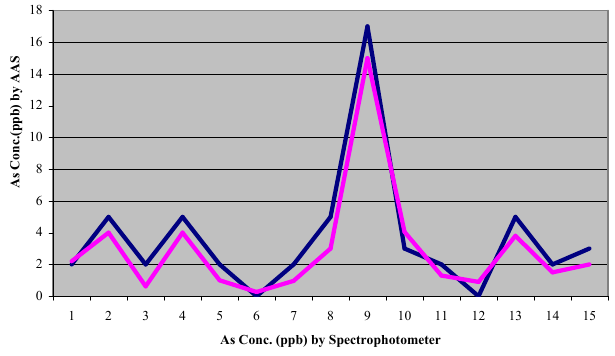
Figure-7: Comparison of Arsenic Analysis Figure 7. Comparison of arsenic